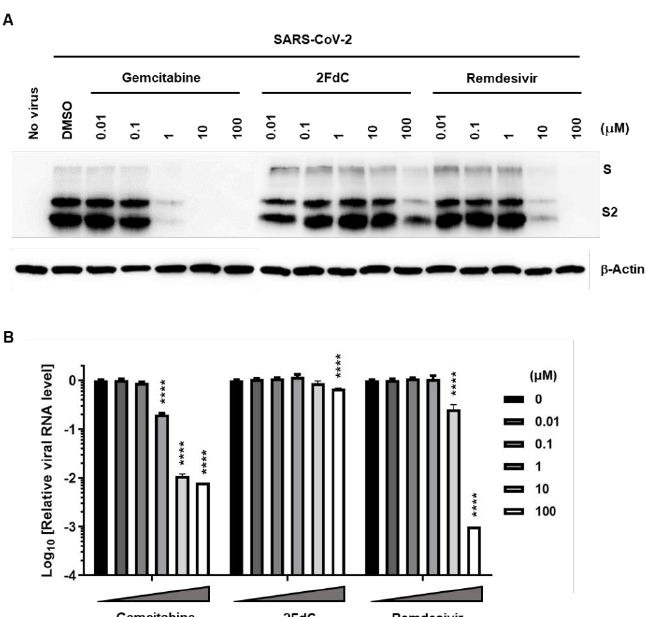
Figure 3. Reduction of viral S protein and viral RNA levels in Vero cells by gemcitabine. ( A ) Western blot analysis probing the S protein. Vero cells in 6-well plates were mock-infected (No virus) or infected with SARS-CoV-2 at an MOI of 0.001 for 1 h at 37 ◦ C. Cells were treated with 10-fold increasing concentrations of gemcitabine, 2FdC, or remdesivir or with a delivery vehicle (0.2% DMSO) for 24 h. Cell lysates were harvested and subjected to 10% SDS-PAGE by loading 30 µ g total protein per well. Full-length S and its cleaved product S2 were visualized using an S-specific antibody (upper panel), with β -actin serving as a loading control (lower panel). Both proteins are labeled on the right side of the gels. ( B ) Real-time RT-PCR was performed using culture supernatants from the same samples used for western blot analysis in ( A ). Viral RNA was amplified using an one-step RT-PCR kit targeting the N gene. The RNA titer from virus-infected, 0.2% DMSO-treated sample was used as a mock control, being set as 1. Changes in viral RNA level are depicted using a log scale from cycle threshold (Ct) values. Values are means ± standard deviations from thee three independent experiments. Multiple comparisons were performed between each test group and the control group by two-way analysis of variance (ANOVA). **** p < 0.0001.